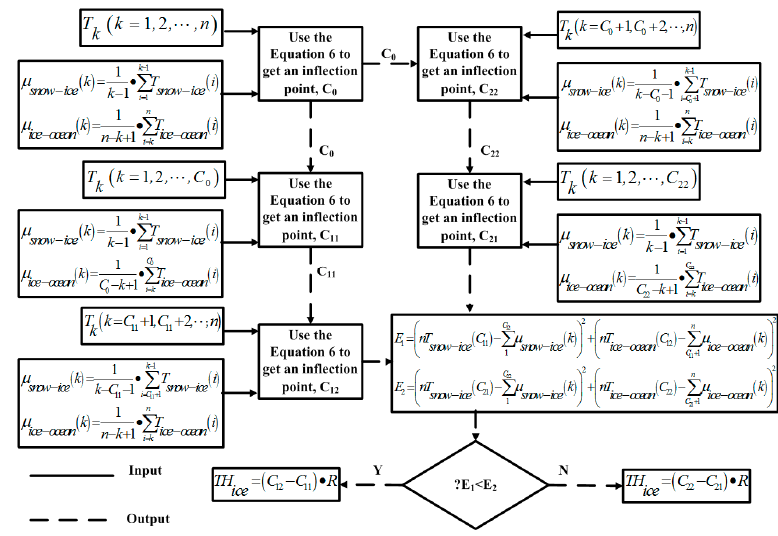
Figure 12. The flowchart of the sea ice thickness discrimination algorithm.